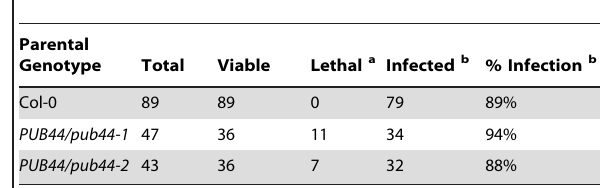
Table 1. Infection rates of Hyaloperonospora arabidopsidis isolate Noco2 at 7 days after infection on Col-0 seedlings or seedlings from PUB44/pub44 parental plants.